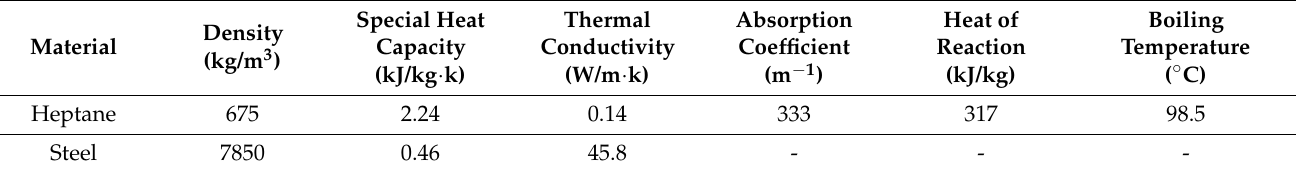
Table 2. Thermal characteristic parameters of heptane and